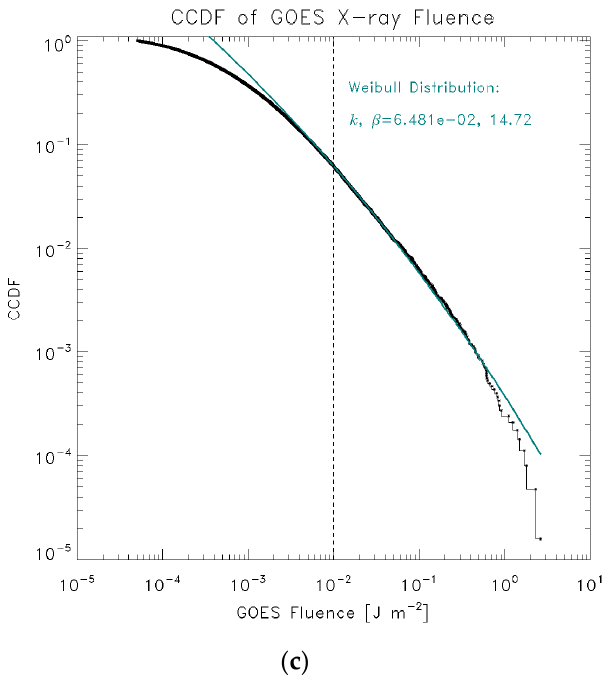
Figure 4. The CCDFs of flare fluence data fitted by ( a ) a tapered power law, ( b ) a gamma function distribution, and ( c ) a Weibull distribution. The vertical dashed line indicates the lower boundary (1 × 10 − 2 J m − 2 ) of data used for fitting.